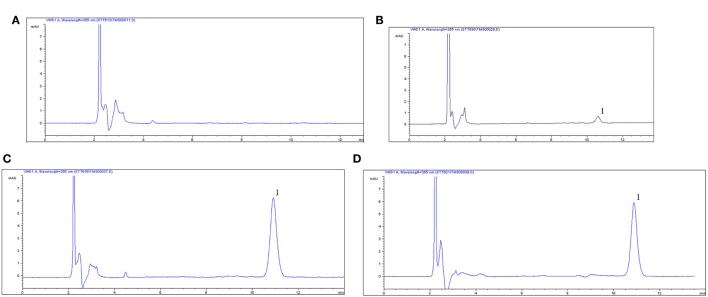
Chromatograms of oxytetracycline (OTC) in plasma. (A) Control blank group in plasma, (B) lower limit of quantification (0.05 µg/ml) of OTC in plasma, (C) chromatograms of plasma at 1 h after i.m. 20% OTC reference injection, (D) chromatograms of plasma at 1 h after i.m. 20% OTC test one, 1, the peak time of OTC.